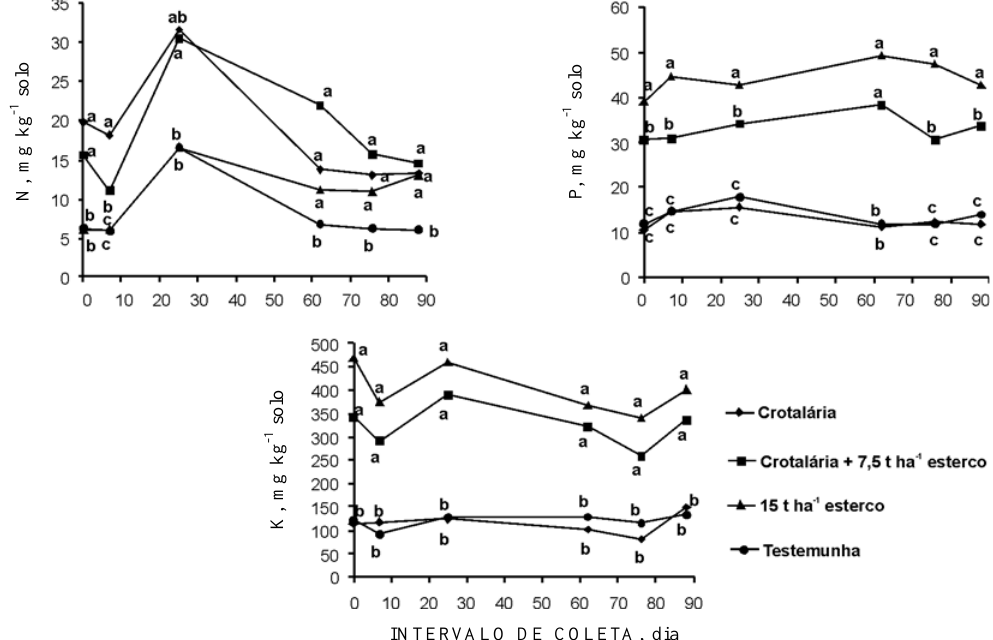
- + N-NH 4+ ) e P e K extraíveis (Mehlich-1), após incorporação de esterco Figura 2. Teor de N mineral (N-NO 3 e, ou, crotalária, em um Neossolo Regolítico, durante o ciclo da cultura da